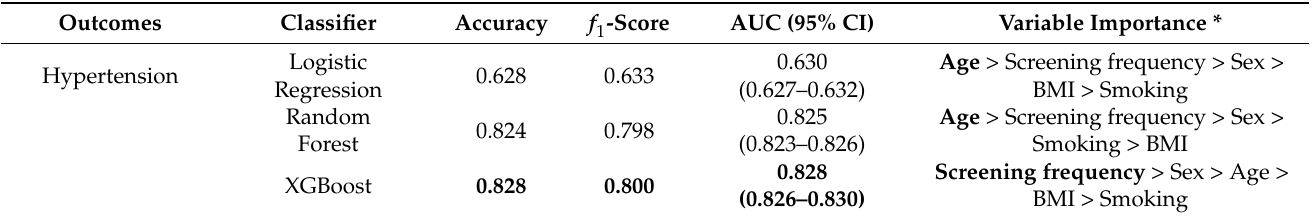
Figure 3. Odds ratios with 95% CIs for hypertension and diabetes mellitus according to screening frequency adjusted by age and sex. Table 3. Model evaluation